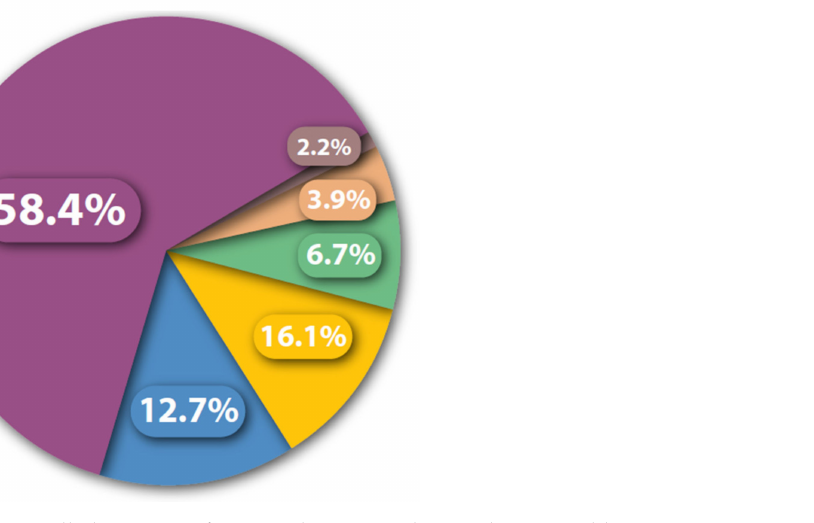
Figure 4. Installed capacity of power plants according to the renewable energy source in